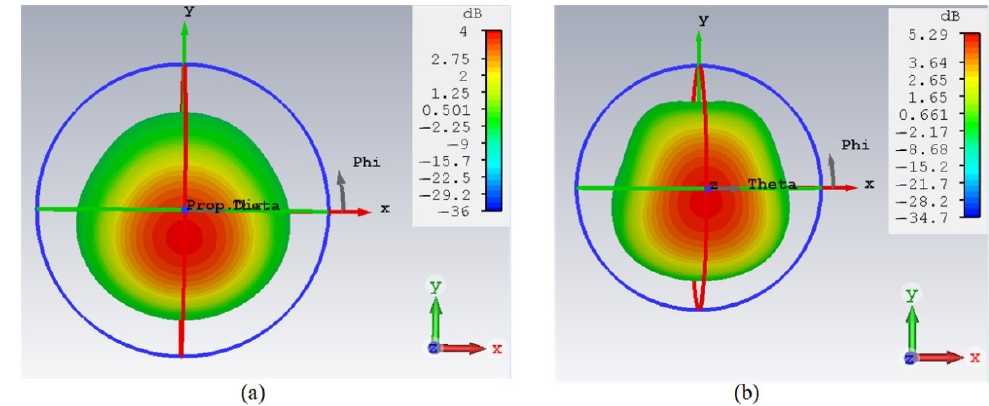
Figure 9. 3D radiation pattern results ( a ) patch antenna without RIS ( b ) patch antenna with RIS.